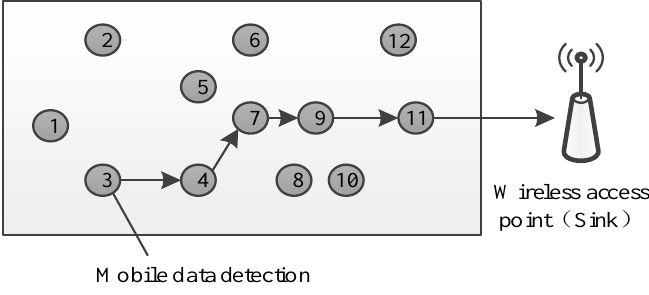
Figure 4. Multi ‐ hop wireless networks. Figure 4. Multi-hop wireless